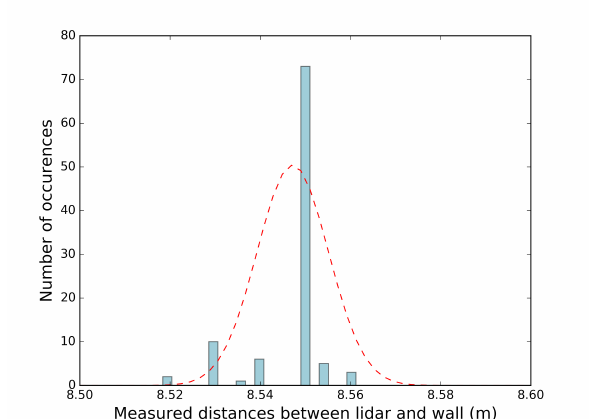
Figure 2: Histogram of 100 distance measurements performed for a single laser point (vertical angle : 0 ◦ , horizontal angle : 0 ◦